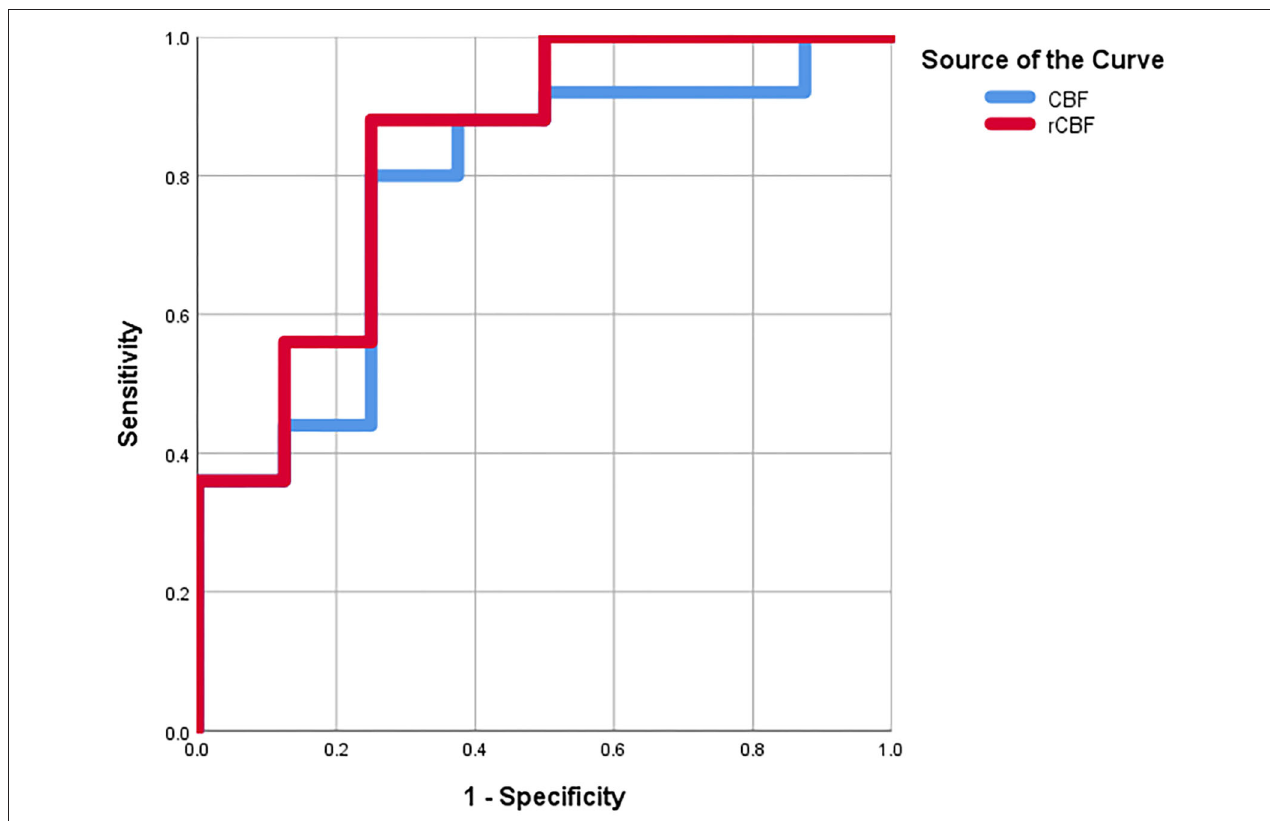
FIGURE 3 | The receiver operating characteristic (ROC) curves for CBF and